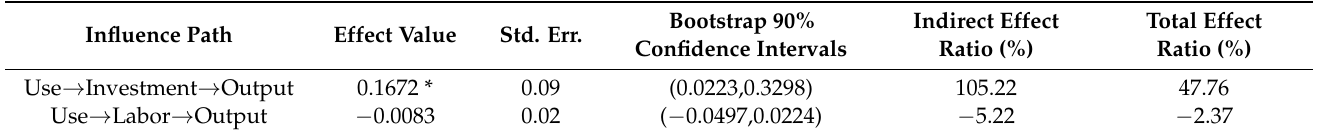
Table 7. Analysis of the indirect effect of use right on forest output.